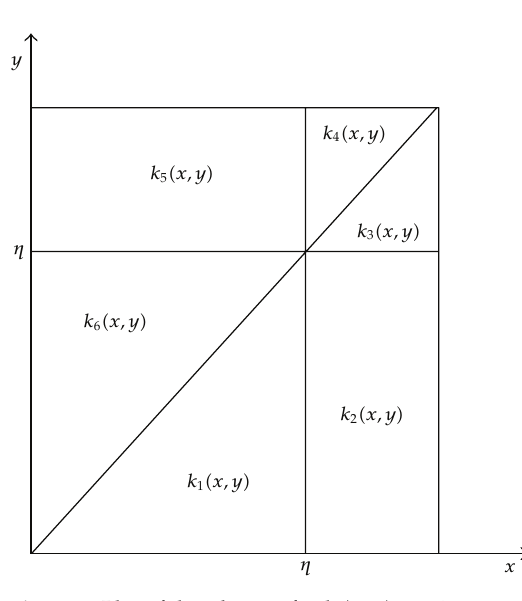
Figure 1: Plot of distribution for k i (cid:6) x,y (cid:7) , i (cid:9) 1 , 2 ,...,